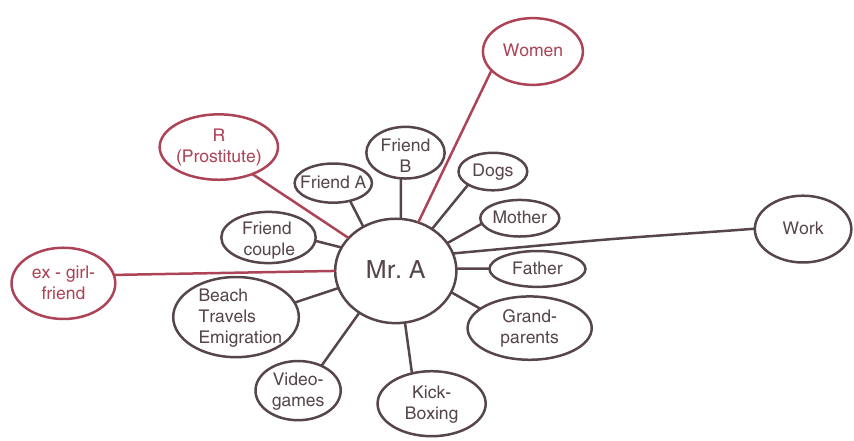
Figure 2. Mr. A’s Social Atom shows problematic affective intimacy to women.